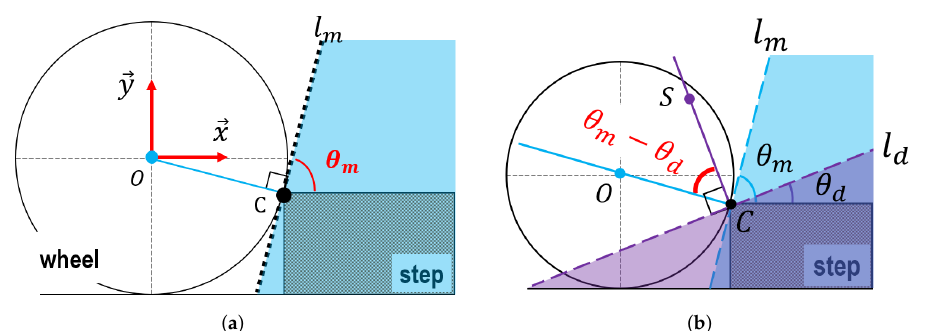
Figure 3. Illustration of step-equivalent gradient model. ( a ) Step-height-based equivalent gradient computation for existing wheels, ( b ) concept of slope minimization for step-height-based equivalent gradient